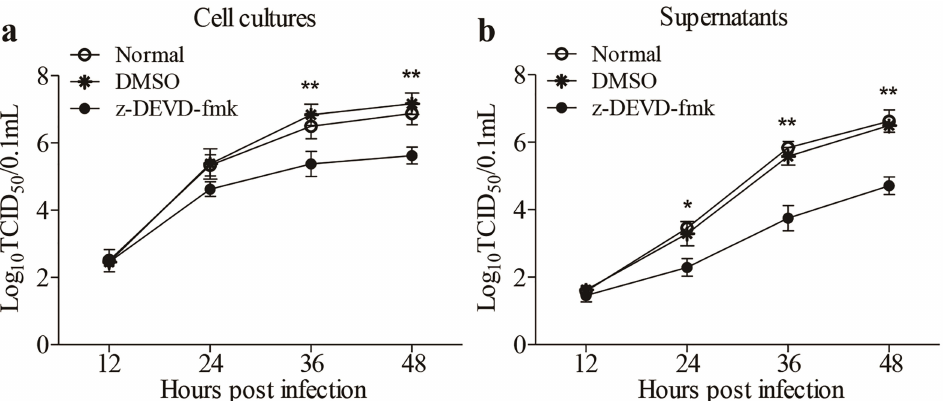
Figure 6. Inhibition of FAdV4-induced apoptosis by caspase-3 inhibitor restricted viral replication. LMH cells treated with z-DEVD-fmk (caspase-3 inhibitor) or DMSO or medium only as controls were infected with FAdV4 at a MOI of 0.1, respectively. At di ff erent time points (12, 24, 36, and 48h) post FAdV4 infection, the viral titers in cell cultures ( a ) and supernatants ( b ) were determined with TCID 50 using 96-well plates. Results are representative of three independent experiments. Data are presented as mean ± SD, n = 3. The significance of the di ff erences between the groups was performed by one-way ANOVA (* stands for p < 0.05, and ** for p <